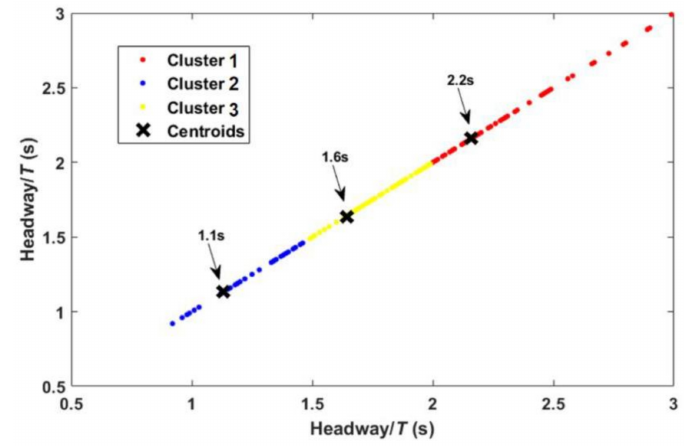
Figure 5. k -means cluster analysis diagram.